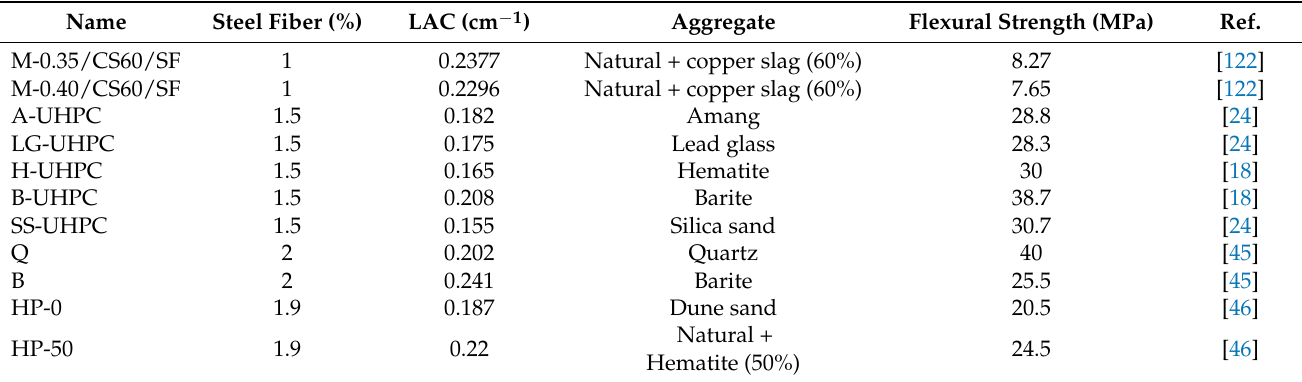
Table 7. List of RSC with flexural strength